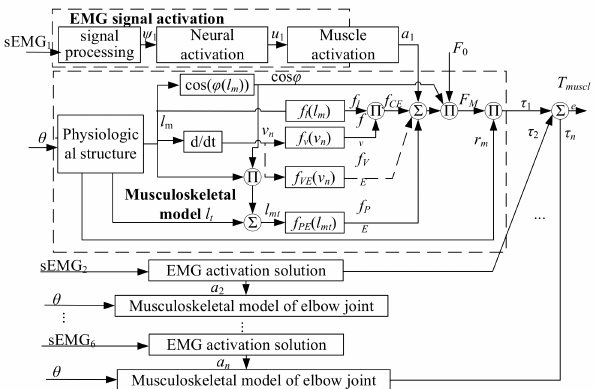
Figure 7. Prediction of elbow muscle torque based on musculoskeletal